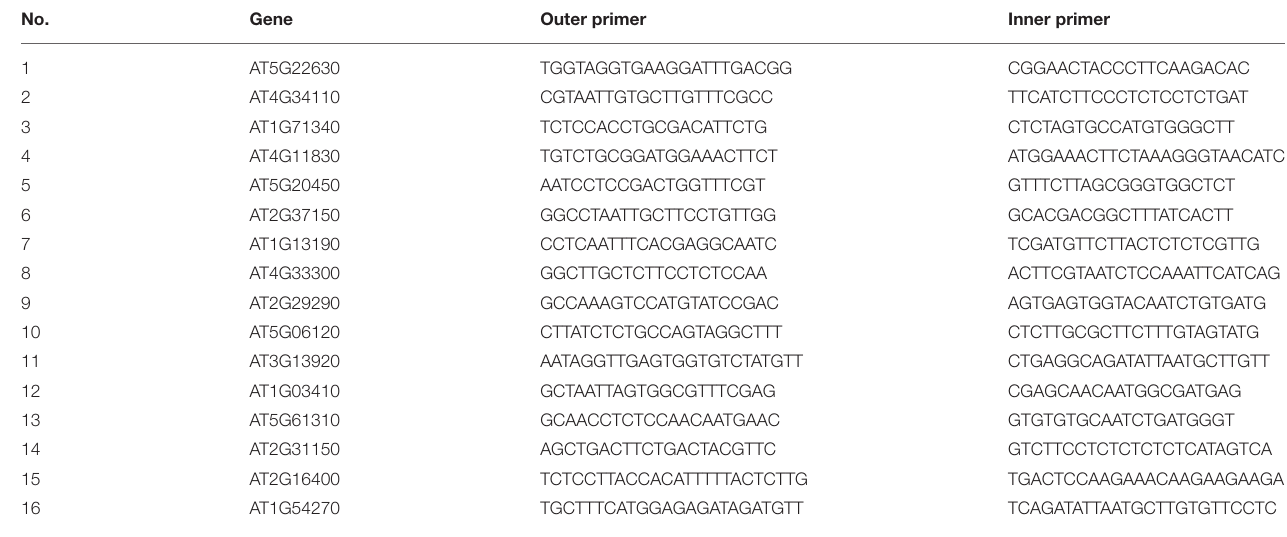
TABLE 1 | Selected genes and gene-specific primers designed for 3 ′ -RACE.